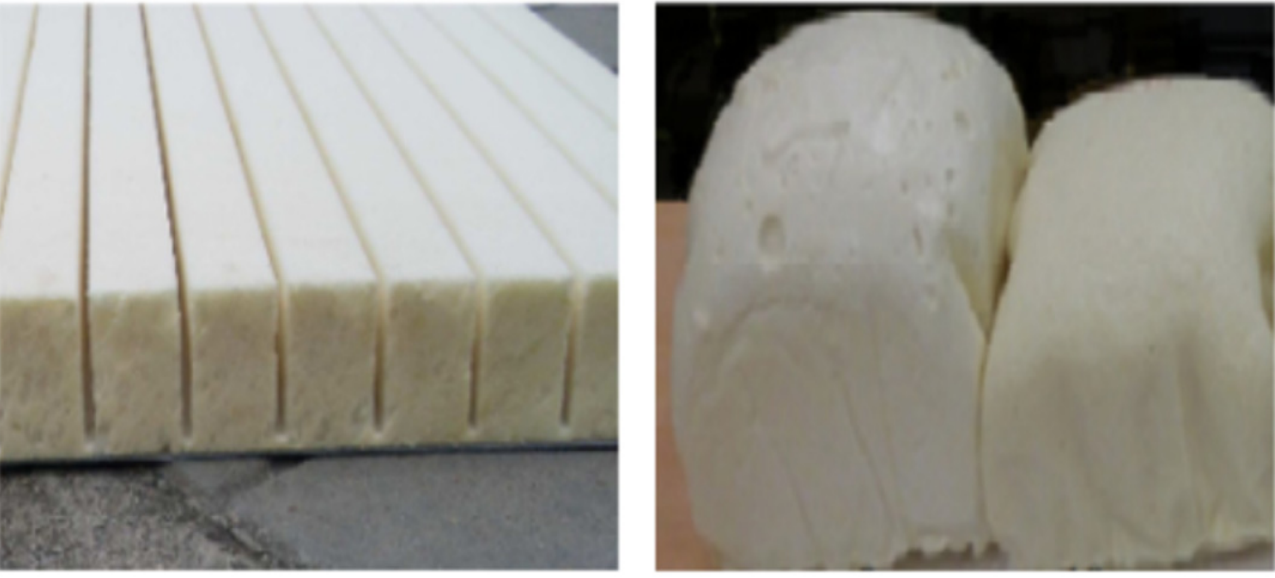
Figure 4. PUR insulation foam